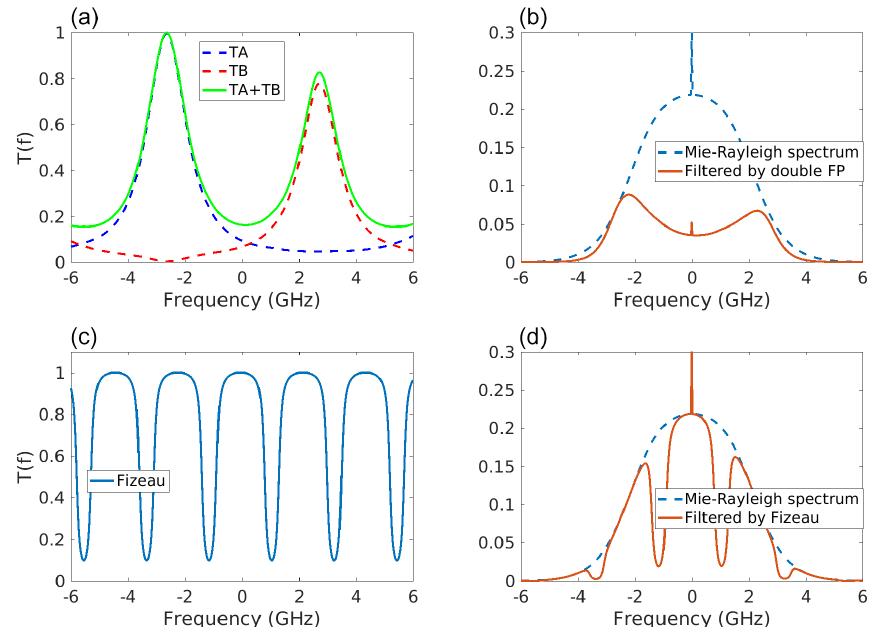
Figure 4. Spectral transmission of the two Fabry–Pérot (a) and Fizeau (c) interferometers, and filtering of a Mie–Rayleigh spectrum by the double Fabry–Pérot (b) and Fizeau (d) . The Rayleigh–Brillouin component of the spectrum is for a temperature T = 300K and a pressure of P = 1000hPa). The Mie contribution of the particulate backscatter is the narrow peak on top. The spectrum used here corresponds to a scattering ratio of 1.0025; i.e. it has a very small Mie peak, for illustration